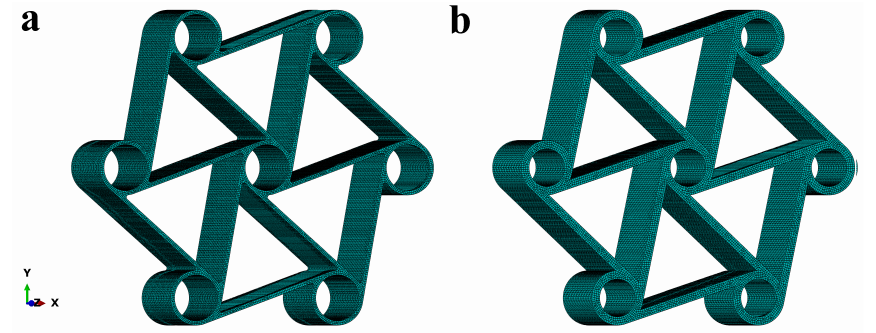
Figure 13. Finite element meshes of ( a ) C1 and ( b )